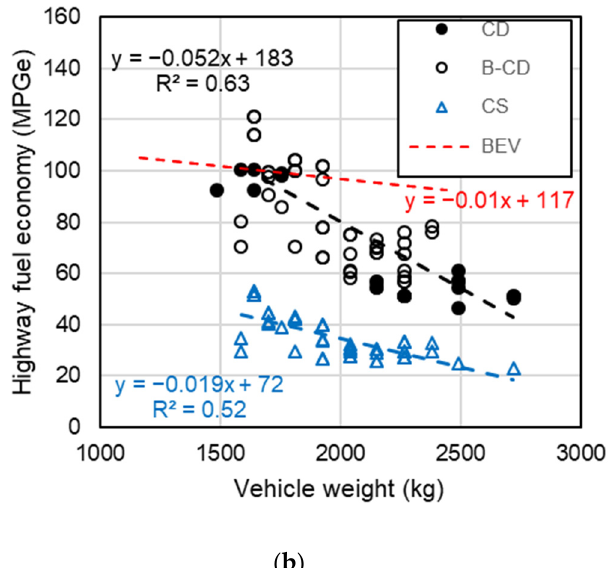
Figure 2. Trend of EPA highway fuel economy (MPGe) with vehicle curb weight (kg). ( a ) Black represents plug-in hybrid electric vehicles (PHEVs) in CD mode, blue represents PHEV in charge-sustaining (CS) mode and red represents BEV. ( b ) Empty black mark represents blended CD mode, solid black mark represents non-blended CD mode, blue represents PHEV in CS mode and red represents BEV.